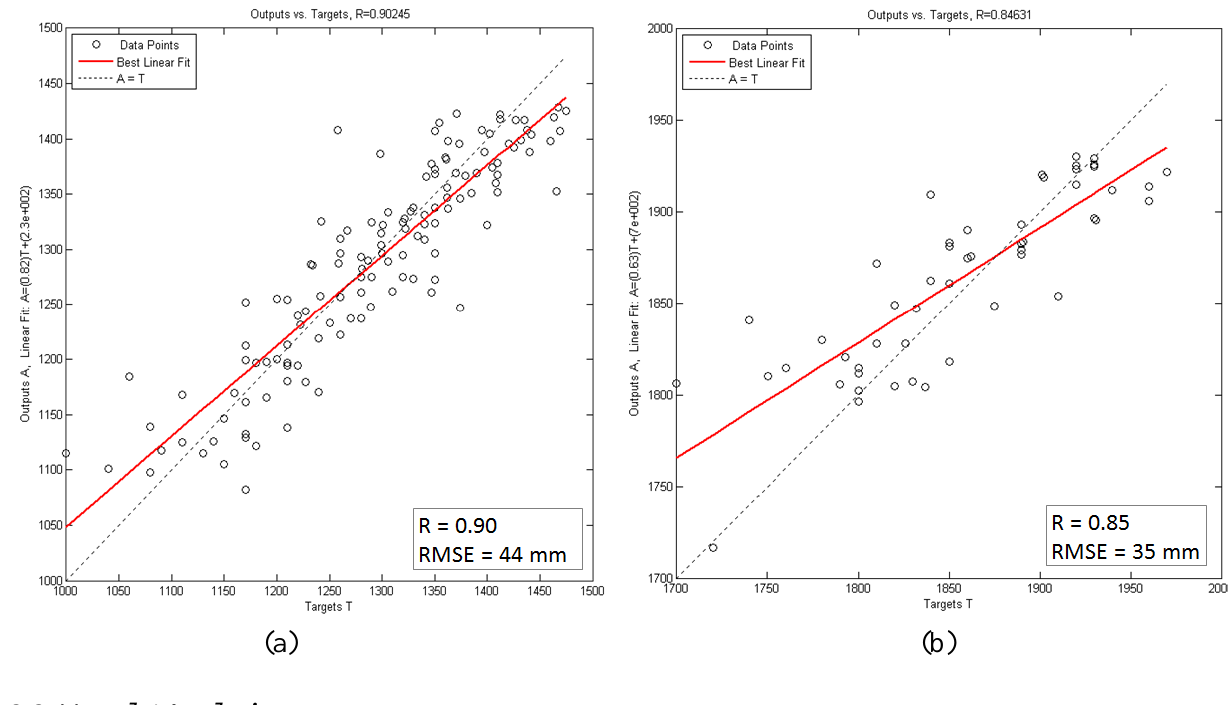
Figure 10. Scatter plots of target and output data: the correlations between the observations and NN outputs for the (a) Antalya-II and (b) Erdek tide